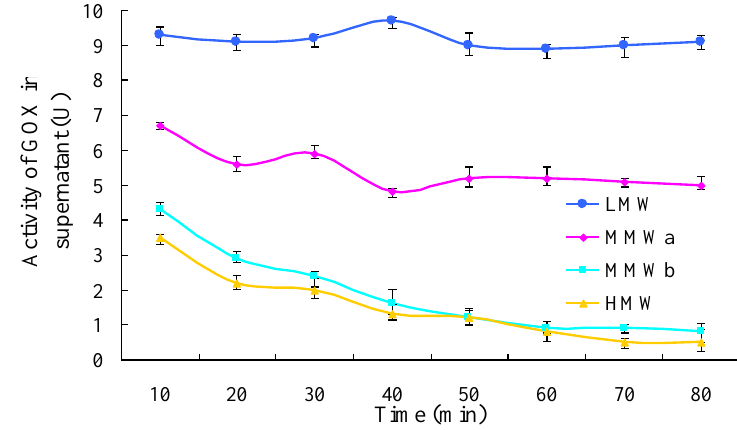
Figure 6. Effect of chitosan molecular weight on GOX encapsulation efficiency.